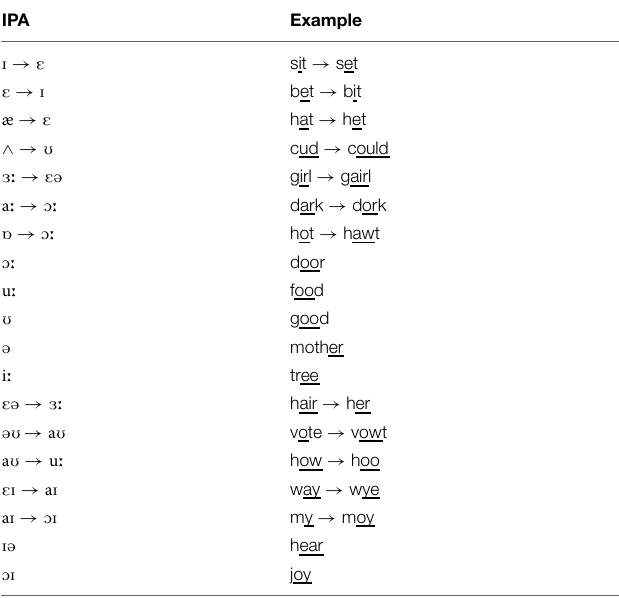
TABLE 1 | Phonetic description of the novel accent.